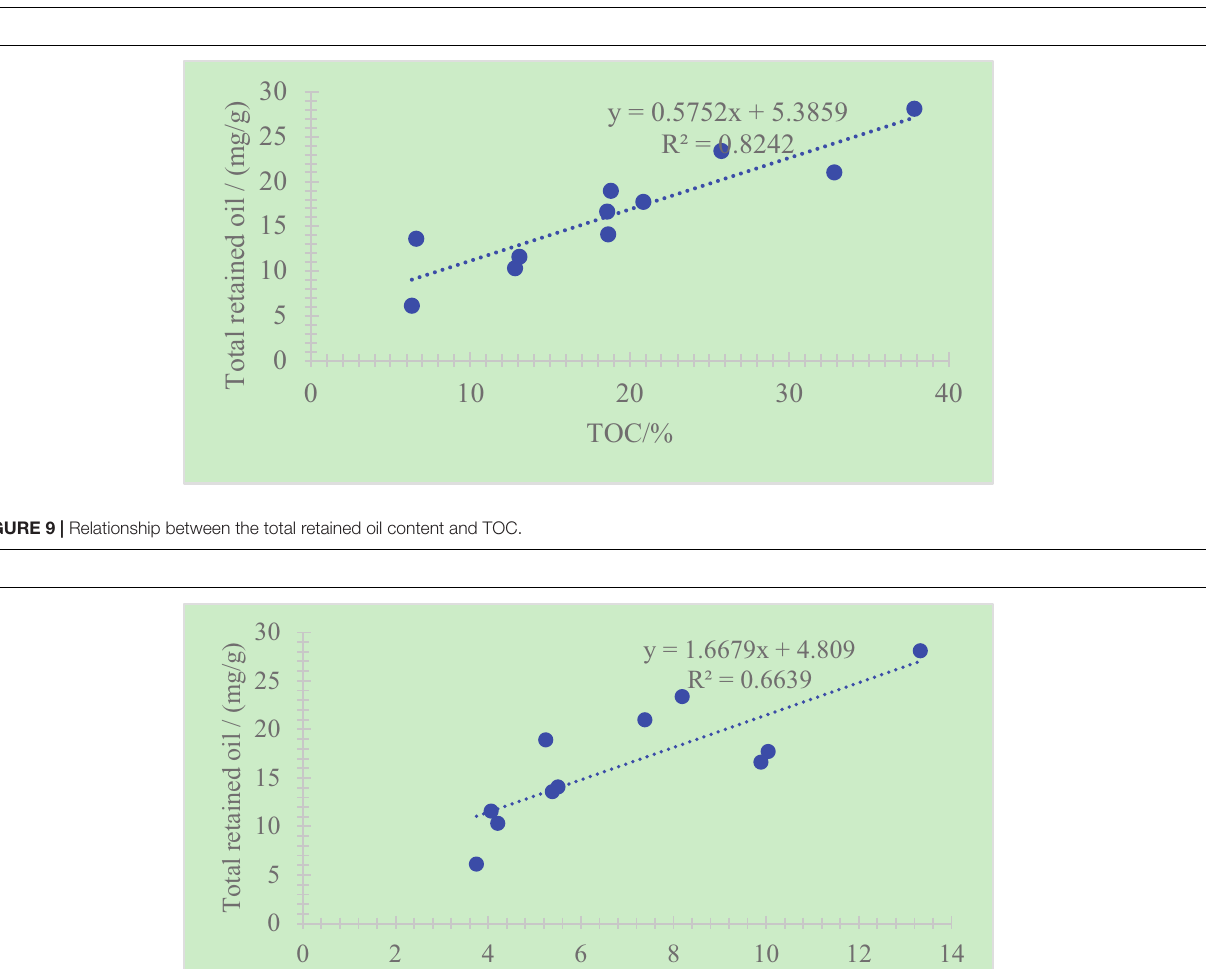
FIGURE 8 | Relationship between the total retained oil content and the extracted sum of dichloromethane and chloroform.